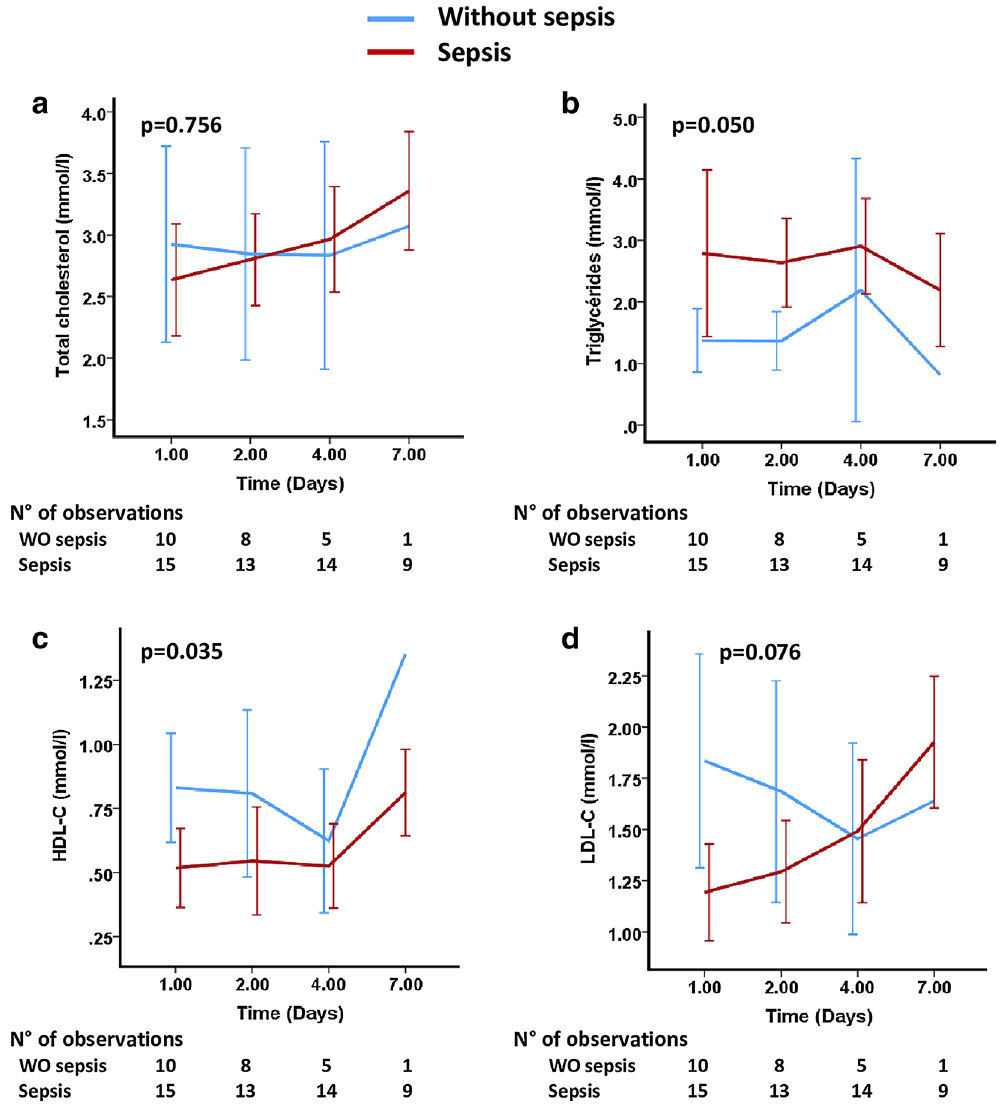
Day 7 data in the group without sepsis is from only one patient. ( a ) Total Cholesterol (TC), ( b ) Triglycerides (TG), ( c ) High-density lipoproteins cholesterol (HDL-C) and ( d ) Low-density lipoproteins cholesterol (LDL-C) concentrations throughout the ICU